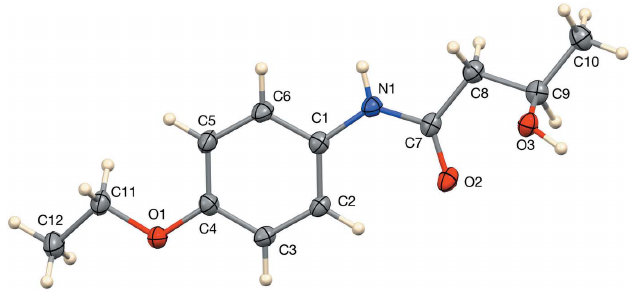
Figure 1 Molecular structure of N -(4-ethoxyphenyl)-3-hydroxybutanamide with displacement ellipsoids drawn at the 50% probability